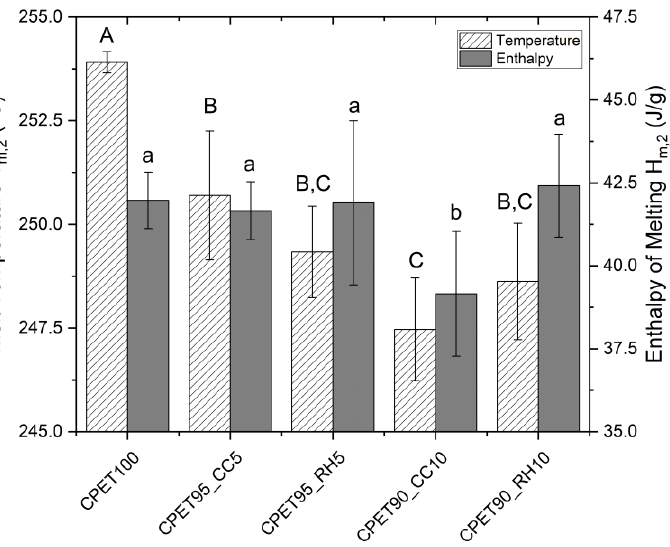
Figure 6. Melt temperature and enthalpy of melting from the second heat cycle. Data points associated with the same letter are statistically equivalent ( α = 0.05); uppercase for melt temperature, lowercase for enthalpy.